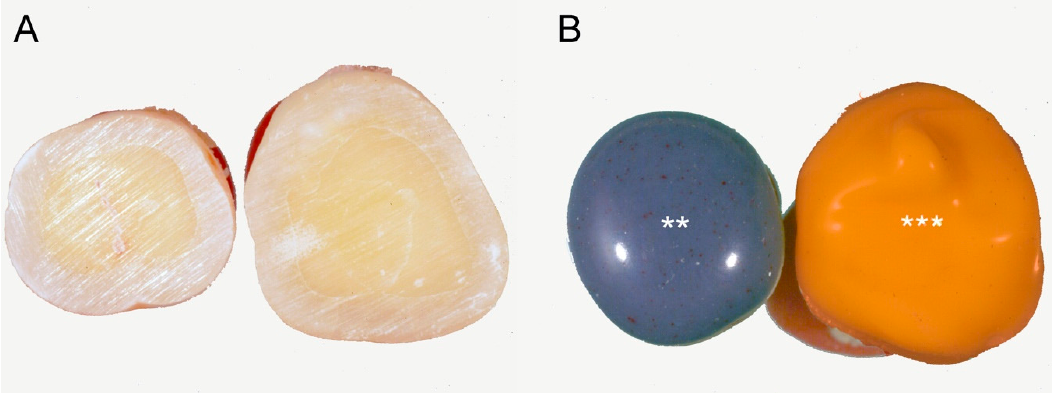
Figure 1. Sample preparation. ( A ) The occlusal dentine was exposed using a diamond bur. ( B ) Impressions taken just after tooth preparation with polyether (**) and polyvinyl siloxane (***).